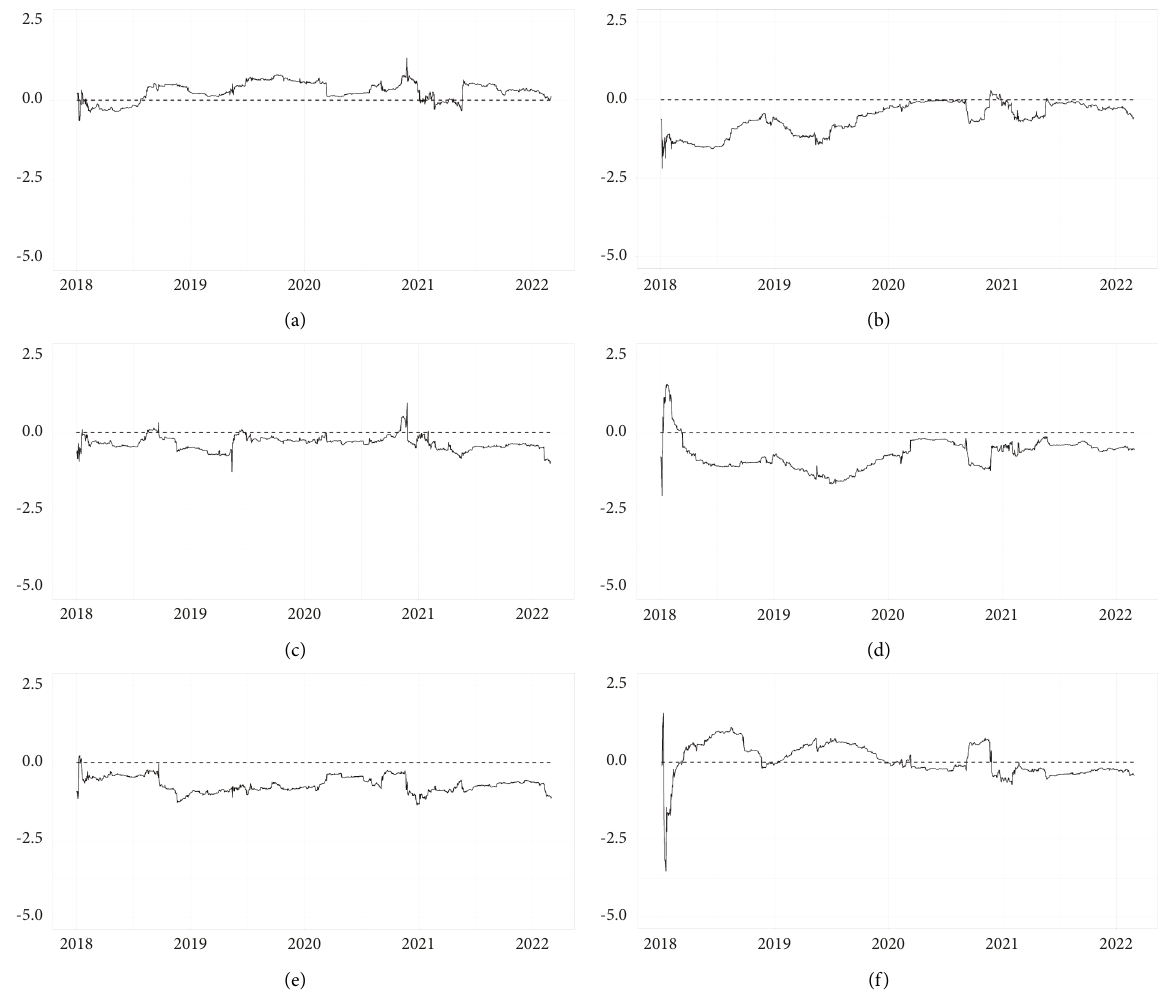
Figure 3: Pairwise net connectedness. This figure describes the pairwise net connectedness. (a) ETH-BTC. (b) BNB-BTC. (c) XRP-BTC. (d) BNB-ETH. (e) XRP-ETH. (f)